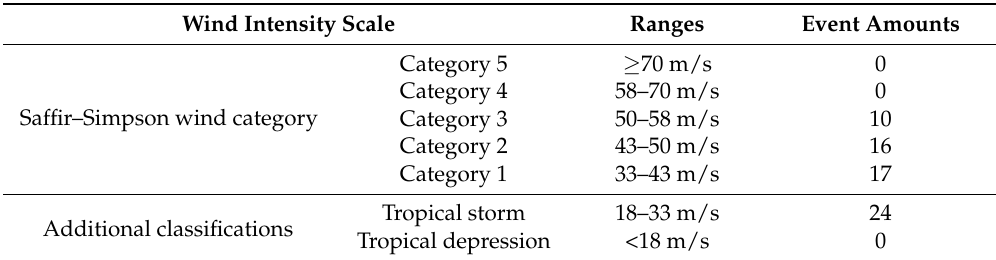
Table 1. Hurricane wind scale and number of 67 collected typhoon